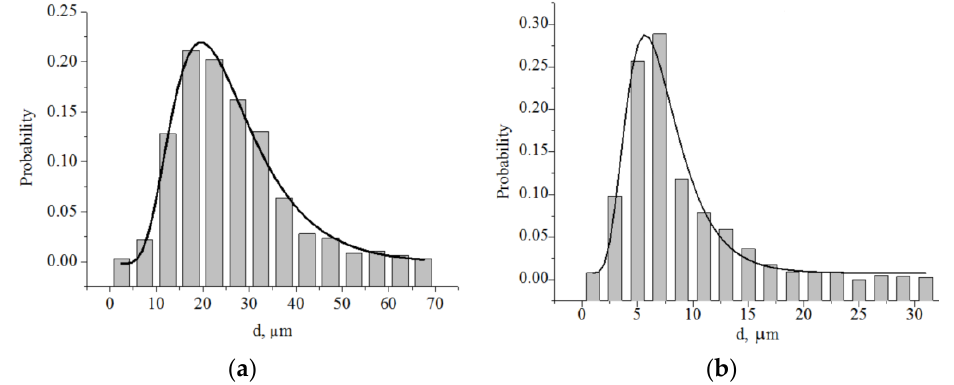
Figure 2. Approximation of grain size distribution histograms to the lognormal function in coatings deposited with ( a ) the commercial electrode (ferrite grains) and ( b ) electrodes modified by 0.25 wt% TiCN nanoparticles (pearlite grains).